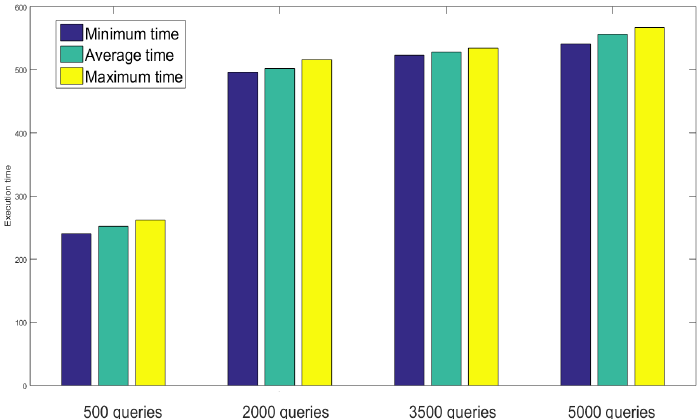
Figure 12. Performance analysis based on sensor query execution time.